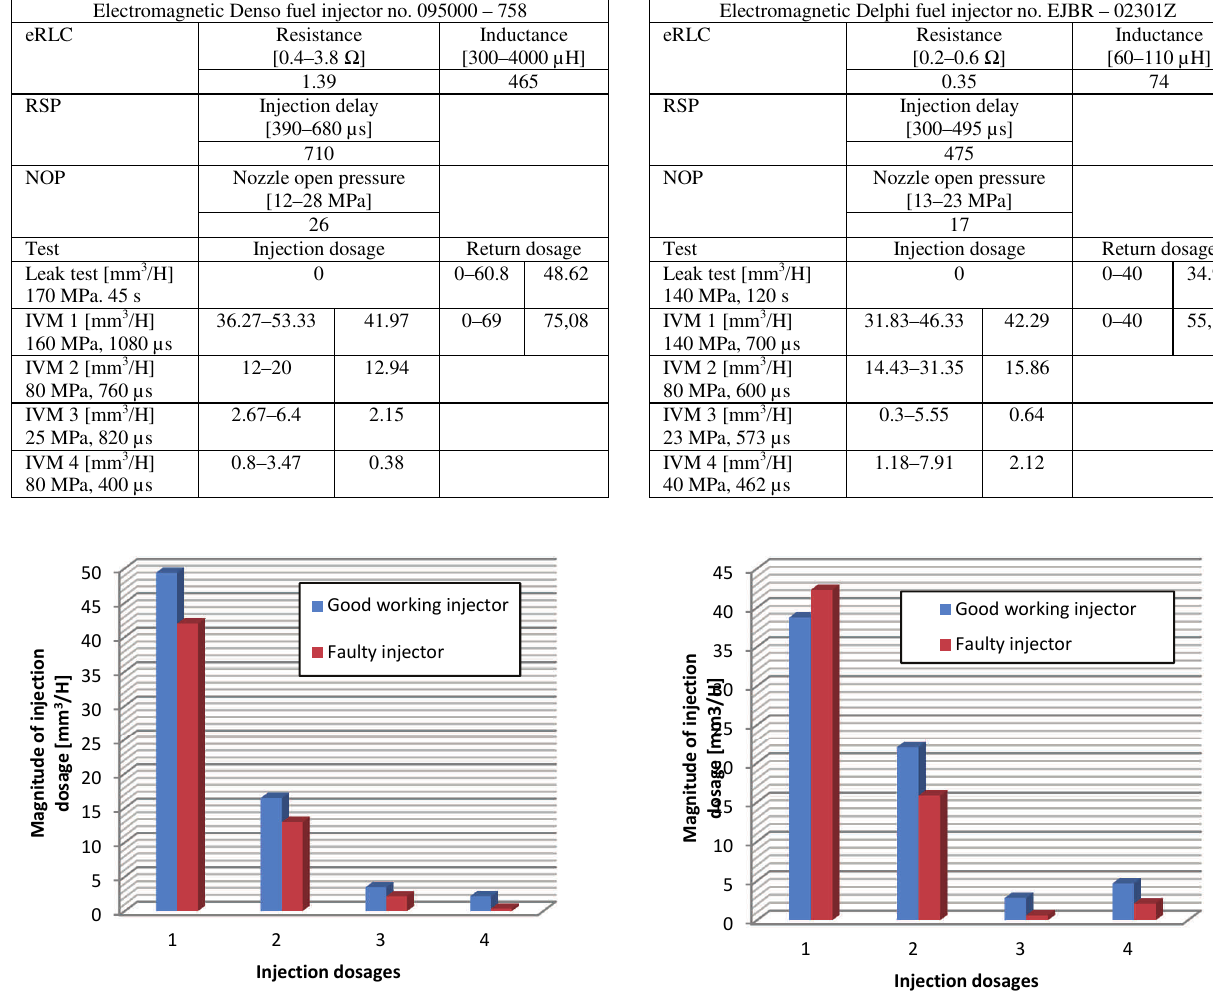
Table 8. Test results of faulty electromagnetic Delphi fuel injector research